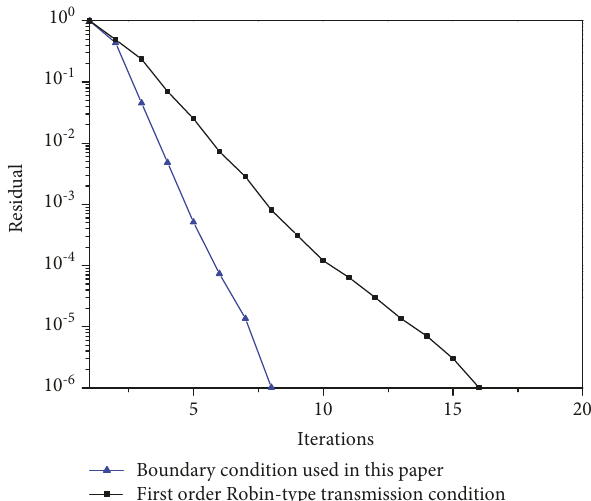
Figure 7: Convergence rate of IE-NDDM with respect to the boundary